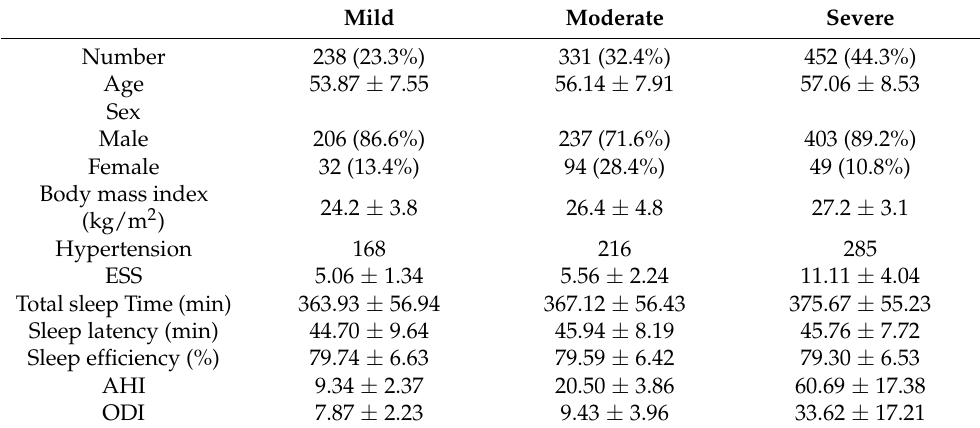
Table 1. Baseline characteristics and polysomnographic parameters.